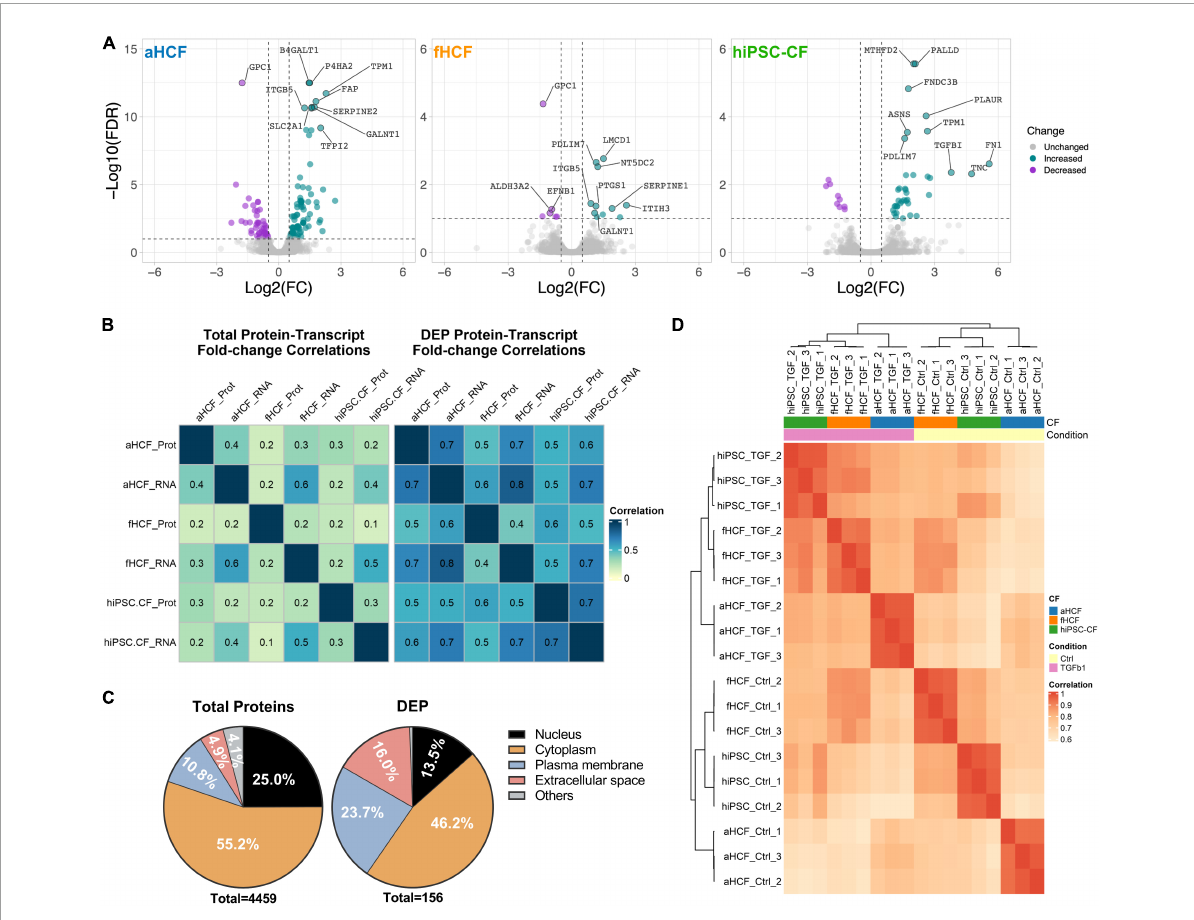
FIGURE4 Proteome remodeling upon CF activation (A) Volcano plots of differentially expressed proteins between control and TGF- β -treated samples, for each CF source. Downregulated proteins are in purple and upregulated proteins in green, non-significant changes are in gray. The top 10 modulated proteins are annotated. Applied thresholds for fold-change: − 0.5 and 0.5; significance: 1. (B) Heatmaps show the Pearson correlation coefficient of fold-changes between transcriptome and proteome considering total protein-transcript pairs ( n = 2,952) on the left panel; and considering protein-transcript pairs corresponding to DEPs ( n = 97) on the right panel. (C) Representativity of cellular locations within the total quantified proteins dataset and within DEPs dataset. (D) Hierarchical clustering of Pearson correlation coefficient considering DEPs annotated as ECM-proteins or membrane